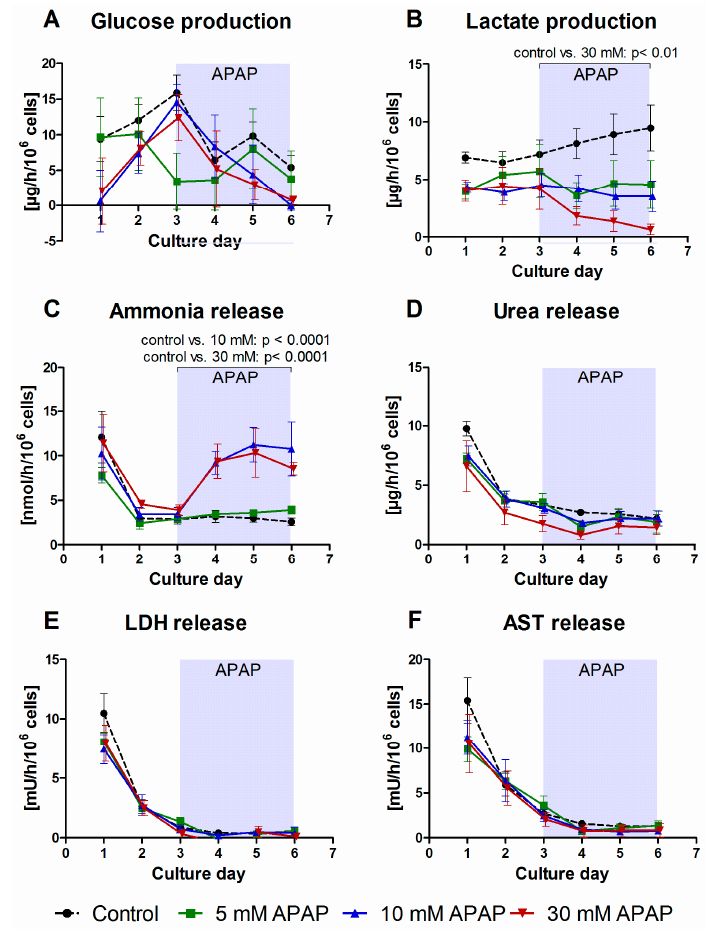
Figure 3. Time-courses of clinical parameters in bioreactors treated with 5 mM, 10 mM or 30 mM acetaminophen (APAP) in comparison to untreated bioreactors used as control group. The figure